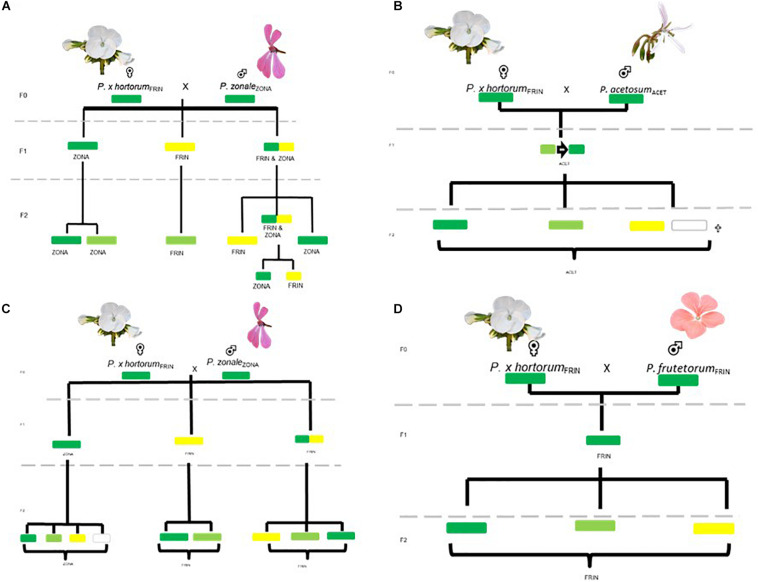
Tracing plastids throughout the pedigrees. Correlation between phenotype and genotype, subsequent segregation in F2 offspring is also indicated. (A,B) TWO HORT × ZONA crosses; (C) the HORT × ACET cross; (D) the HORT × FRUT cross. Text in subscript denotes the plastid type found in the parental population.